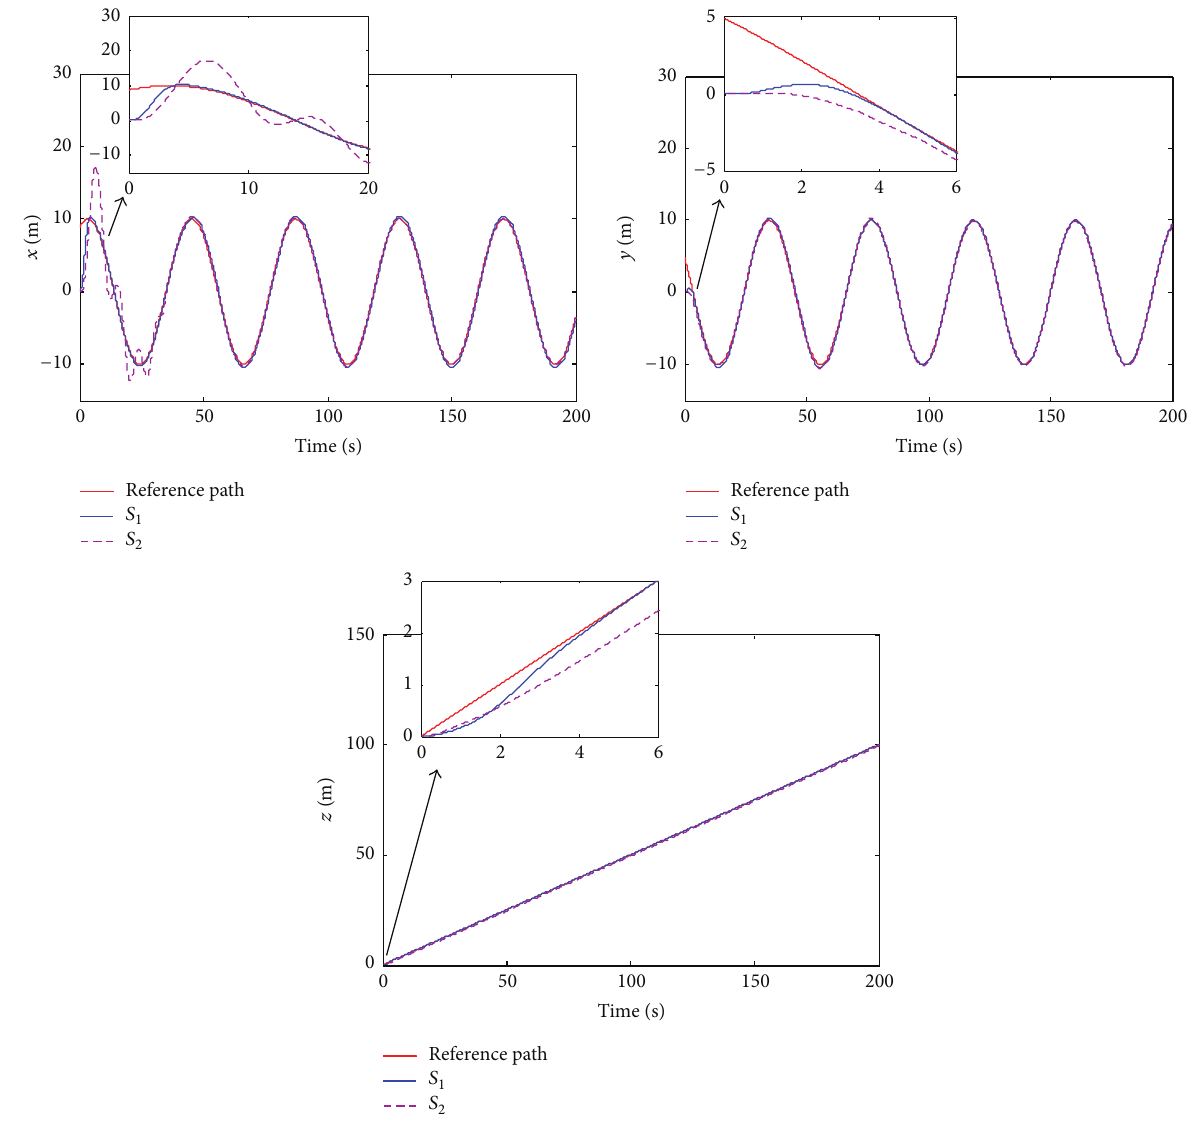
Figure 4: UAV flight path tracking results of the positions (𝑥,𝑦,𝑧)